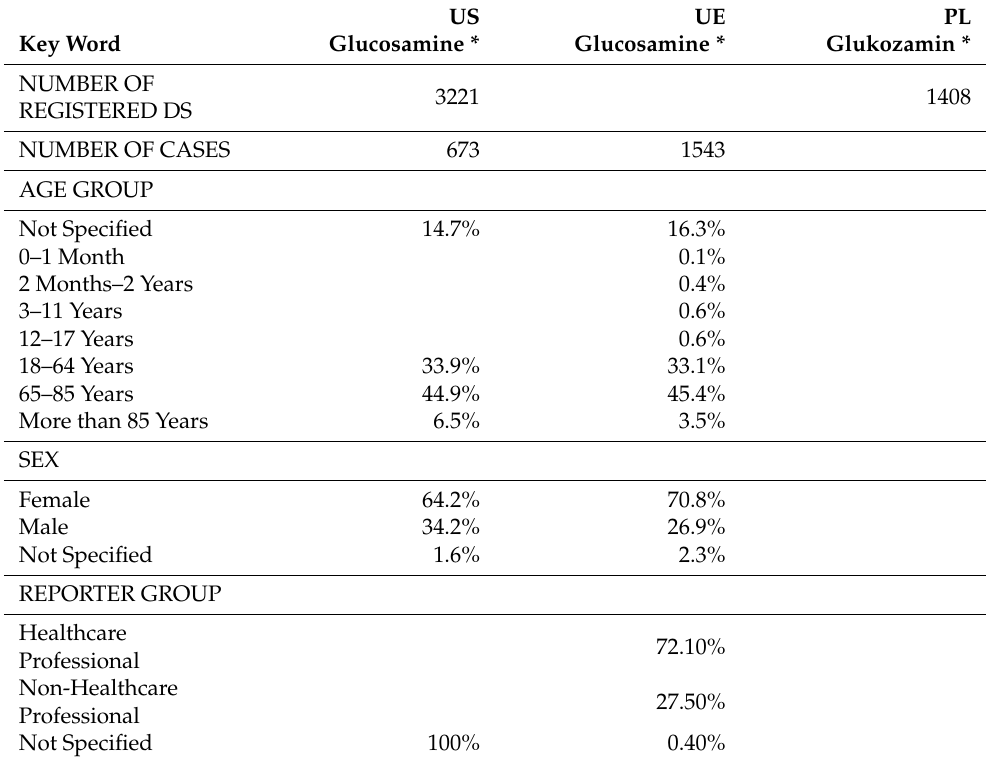
Table 5. Comparison of data on Glucosamine from different databases.